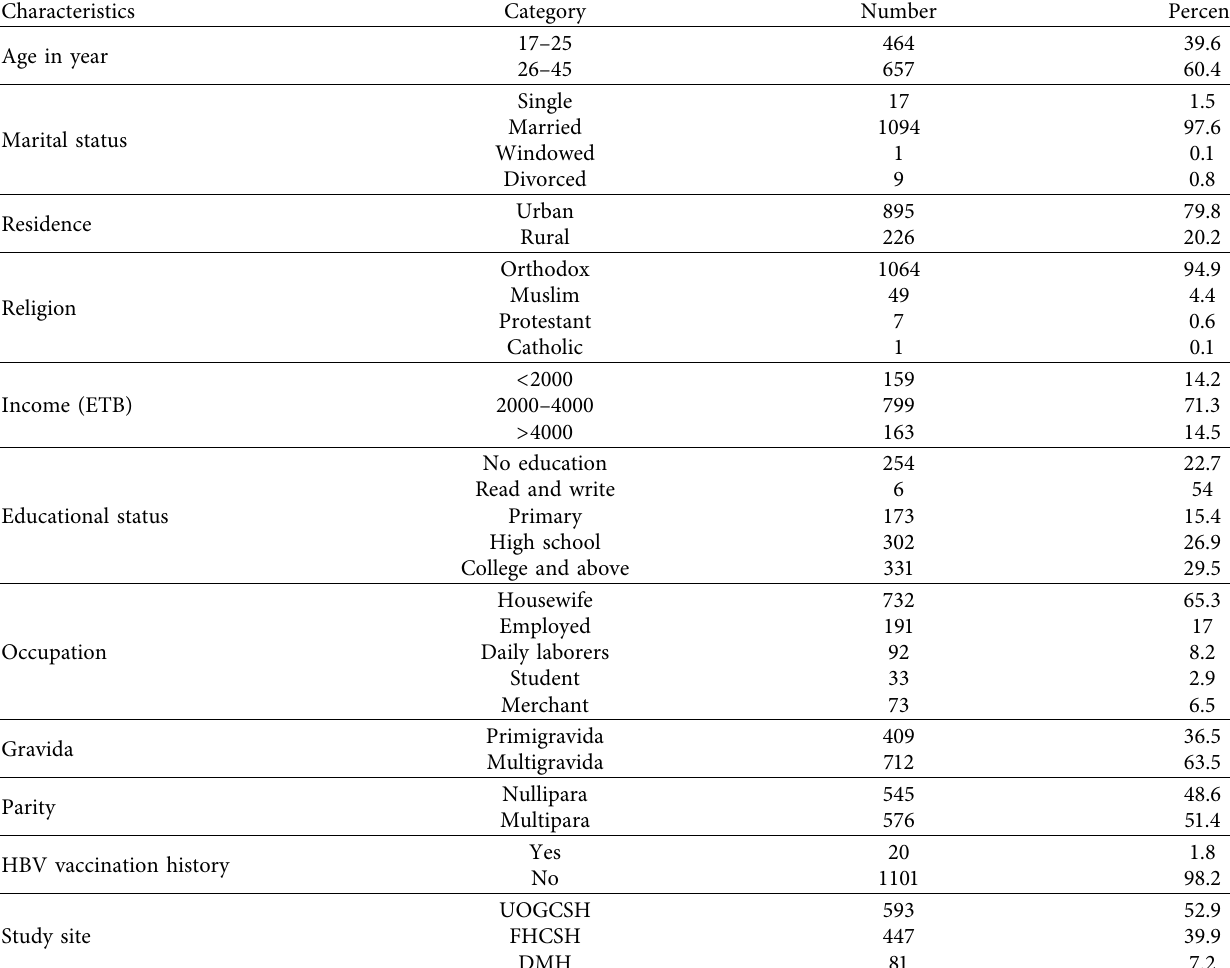
Table 1: Sociodemographic characteristics of pregnant women attending the Amhara national regional state in three tertiary hospitals from May 1, 2018, to September 30, 2019.